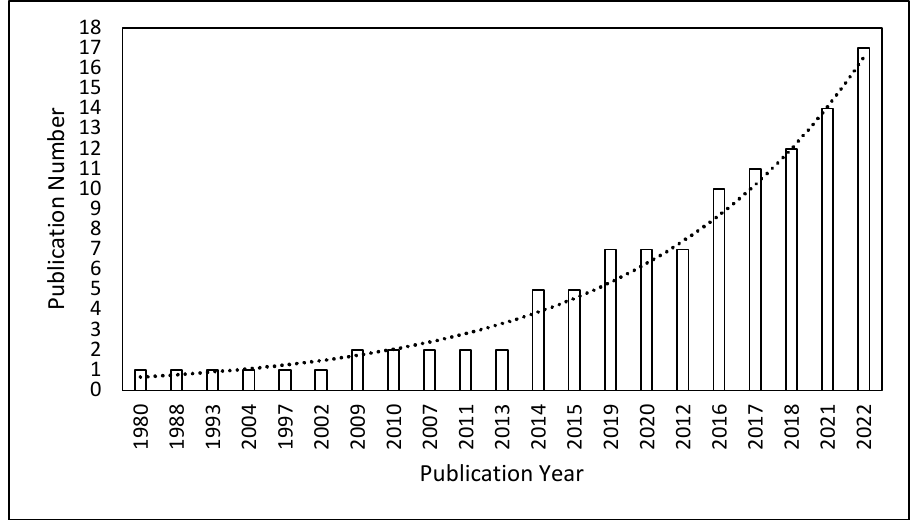
Figure 3. The development trend of studies for biogas purification. (The horizontal line indicates time, and the vertical line indicates the cumulative number of related works in each year).